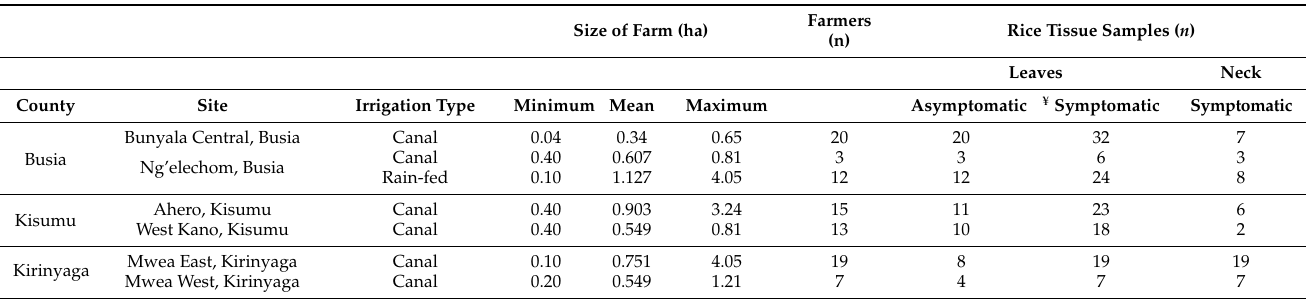
Table 1. Sites, irrigation types, farm sizes, number of farmers, and samples that were included in a survey conducted in the major rice areas of Kenya in